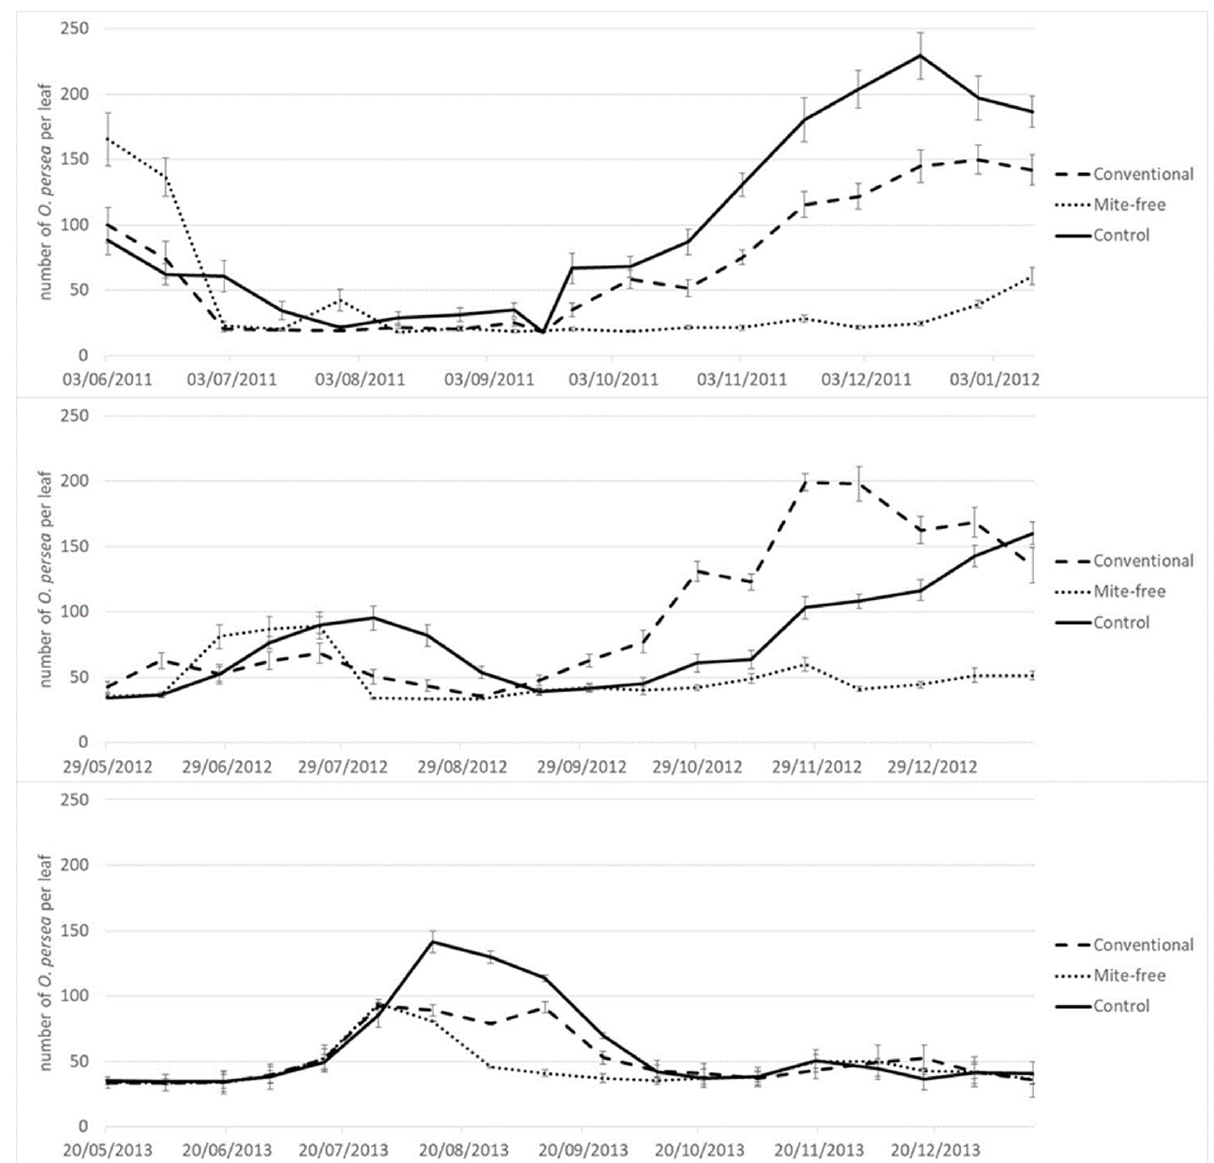
Figure 1. Population dynamics of the Persea mite on avocado trees in Tenerife subjected to different treatments in 2011–2013.